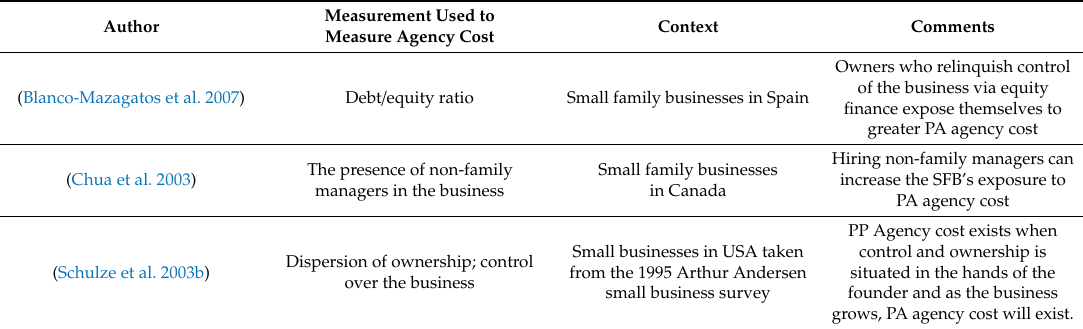
Table 2. Measurement of agency cost for small businesses used in the